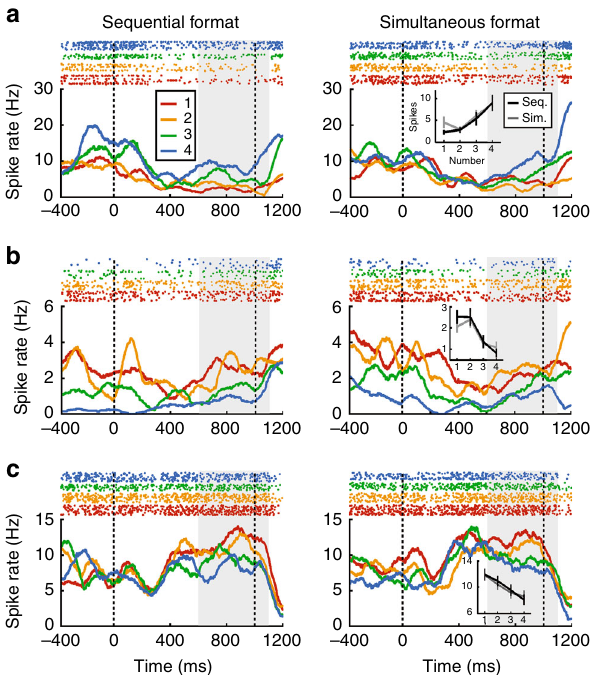
Fig. 4 Neuronal responses during the delay. Example responses of delay neurons shown separately for sequential (left column) and simultaneous presentation formats (right column). Example neurons prefer numerosity 4 ( a ), 2 ( b ), and 1 ( c ). Top panels: dot-raster histogram, bottom panels: averaged spike density functions. Dashed lines indicate delay on- and offset. Gray shaded area signi fi es the ANOVA analysis window. Insets: Average activity of the respective neuron to numerosity during both presentation formats (error bars indicate ± SEM).